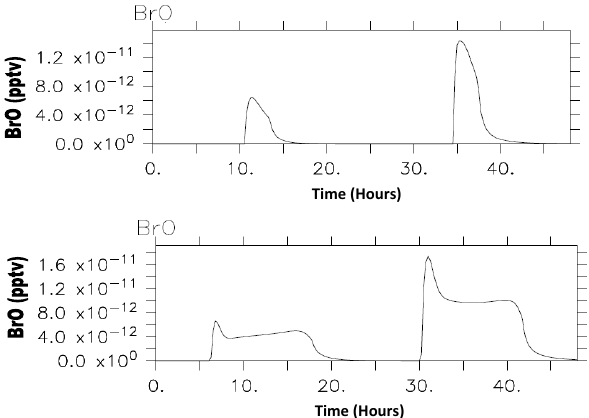
Fig. 6. BrO model output from MISTRA 0-D showing (a) a single BrO peak around noon when solar declination is set to represent early spring at Halley; and (b) a double BrO peak with a maximum in the morning and evening, with a noon time minimum when solar declination is set to represent late spring at